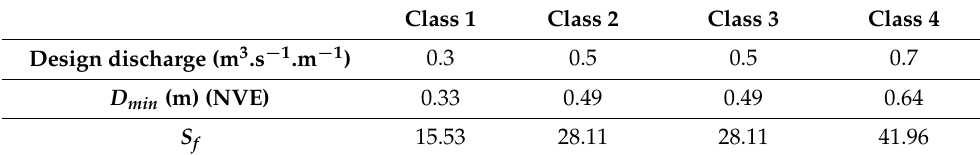
Table 3. Computed minimum riprap size values for each consequence class dam. Class 1 Class 2 Class